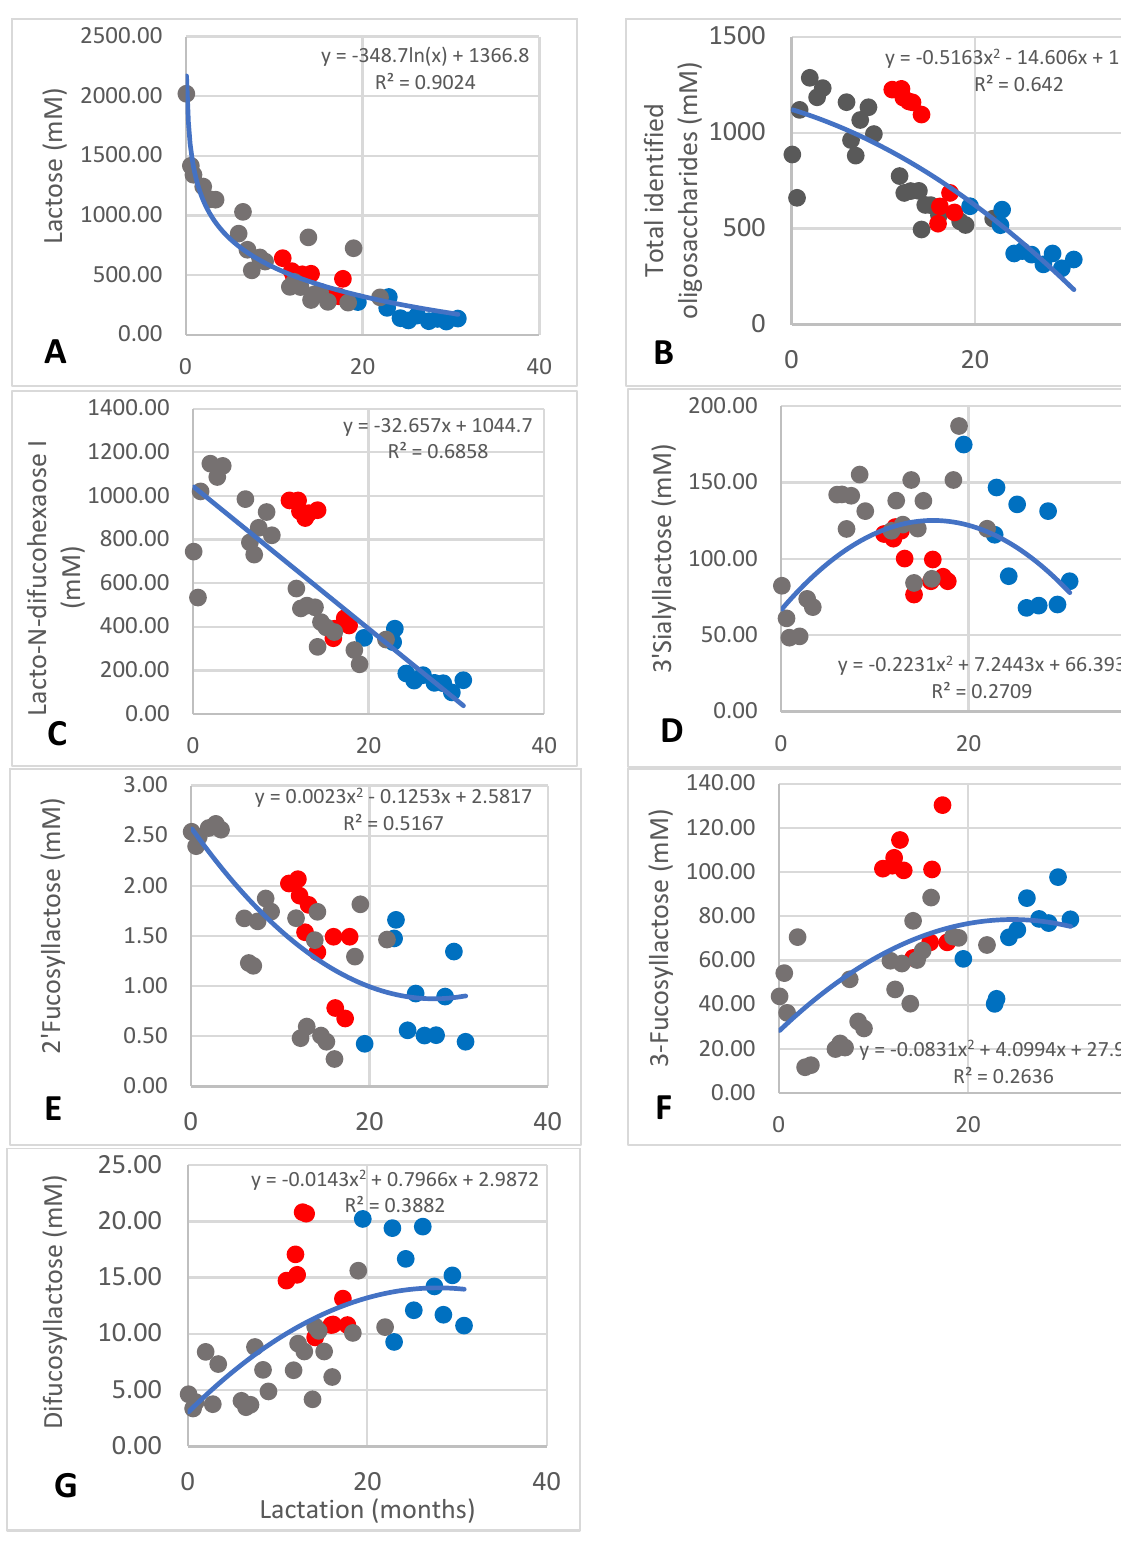
Figure 2. Changes of identified saccharides: lactose ( A ), total identified oligosaccharides ( B ), lacto-N- difucohexaose I ( C ), 3 (cid:48) -sialyllactose ( D ), 2 (cid:48) -fucosyllactose ( E ), and 3-fucosyllactose ( F ) and difucosyl- lactose ( G ) in milk of African elephants (Shorty • , Mussina • , Shan • ). Trend lines, formulas, and R 2 values were calculated from the combined data of the three